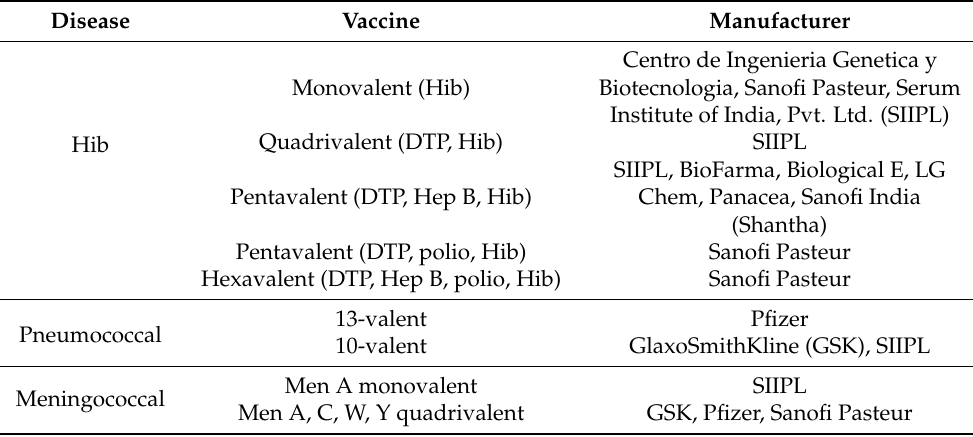
Table 1. World Health Organization (WHO) prequalified Hib, pneumococcal, and meningococcal conjugate vaccines